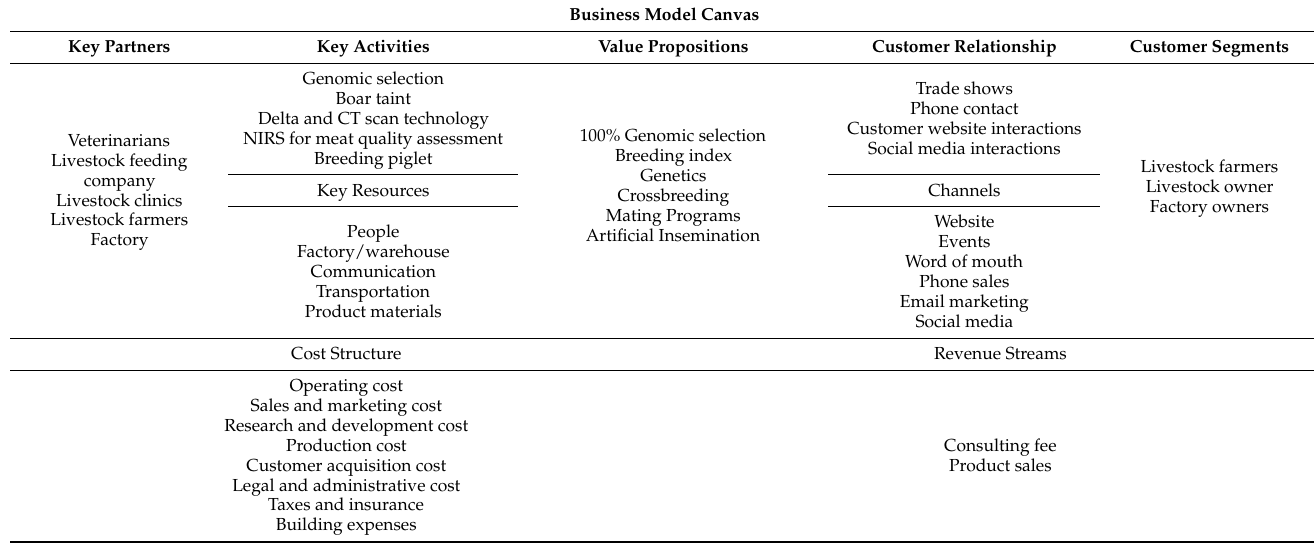
Table 3. Overview of market research analysis of the 3-in-1 multimodal sensor platform for the livestock genetics